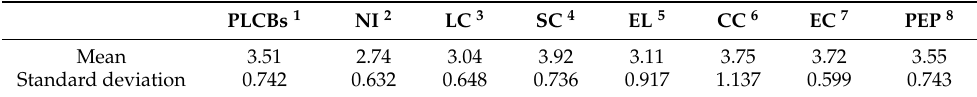
Table 1. Descriptive statistics of